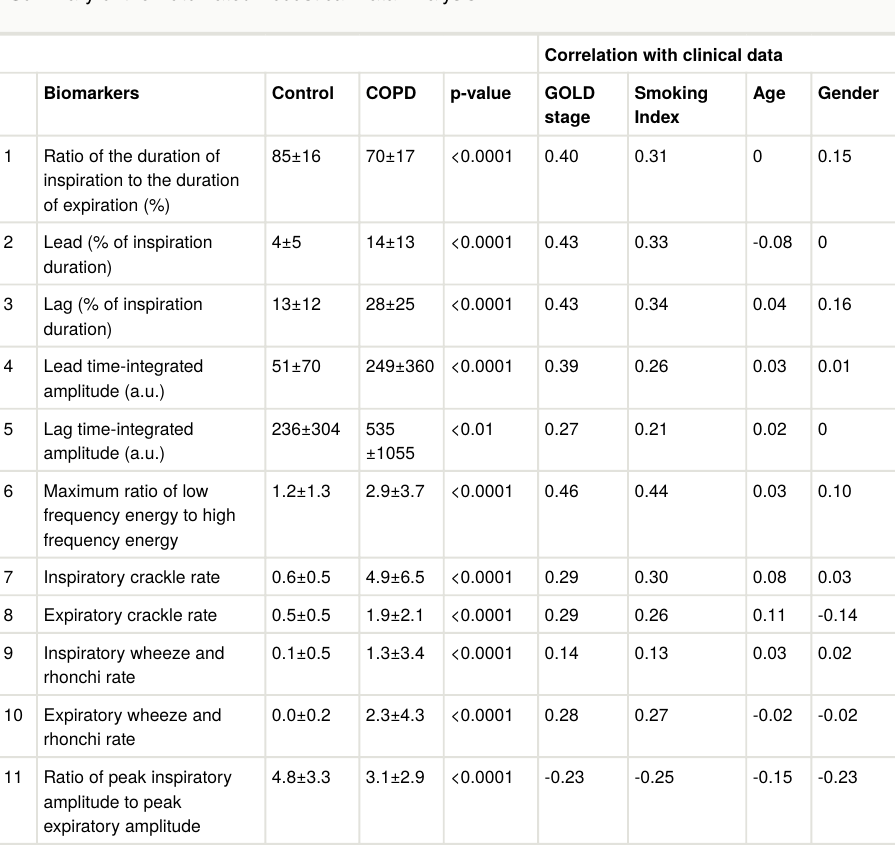
Summary of the Automated Acoustical Data